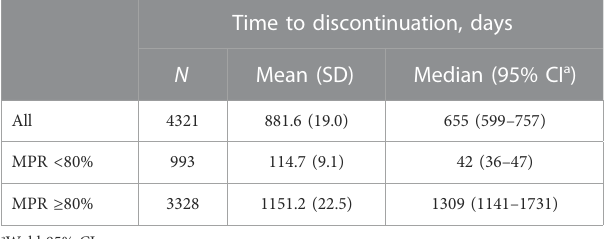
TABLE 3 Time to discontinuation of a potassium binder in the overall population (all patients and patients strati fi ed by